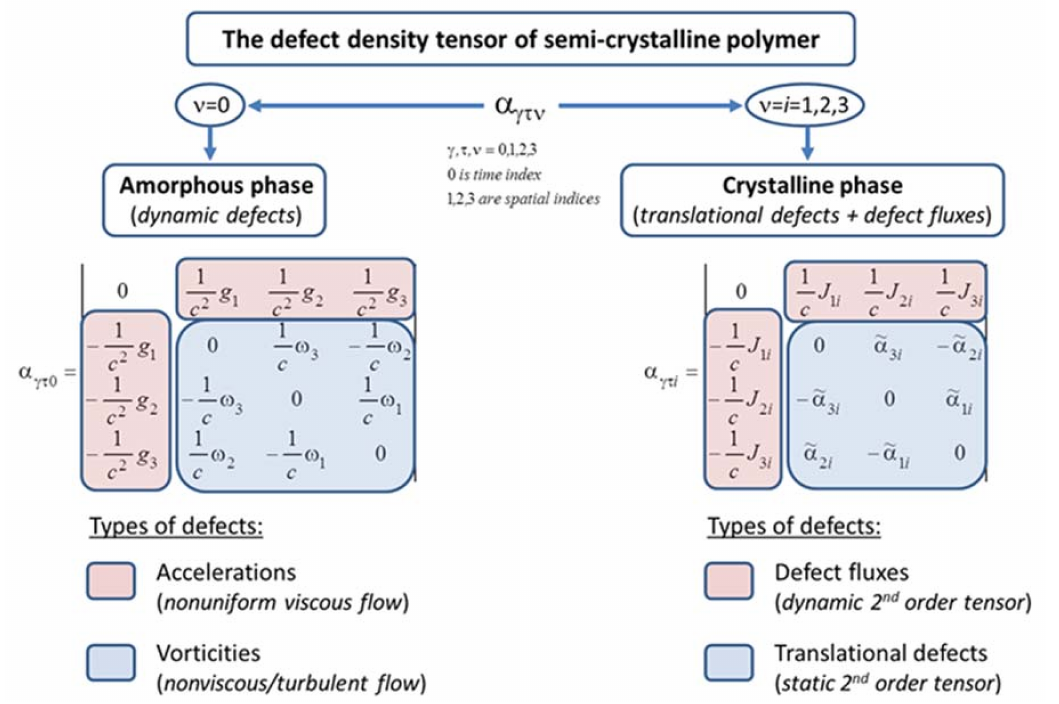
Figure 2. Contributions to the defect density tensor from defects in amorphous and crystalline components of a semi-crystalline